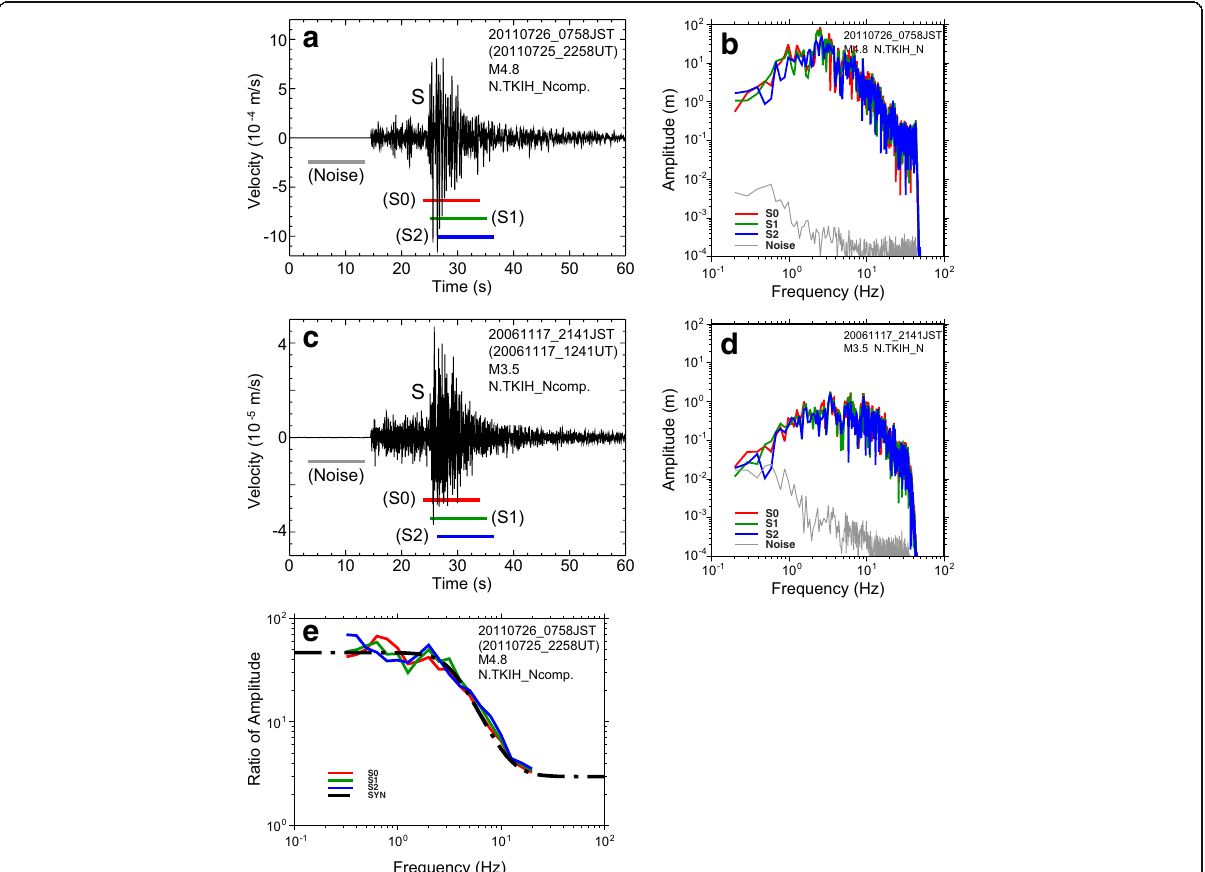
Fig. 3 a Example of an analyzed waveform of an earthquake with M4.8. The color lines indicate the three time windows used in deconvolution, which were (S0) − 0.50 to 9.73 s, (S1) 0.78 to 11.01 s, and (S2) 2.06 to 12.29 s after the S arrival. The gray line shows a time window from 12.00 to 1.77 s before the arrival time of the P wave, which was used to calculate the spectrum of a noise in ( b ). Each time window has 1024 data points. b Spectra of waveforms for the four time windows shown in ( a ). c Example of a waveform of an M3.5 earthquake that was used for an EGF. Note that the vertical scales in ( a ) and ( c ) are different. d Spectra of waveforms for the four time windows shown in ( c ). e Deconvolved spectra with the fitted omega-squared model. The color lines are deconvolved source spectra, that is, ( b ) divided by ( d ), for three individual time windows with a resampling of frequency bands. The black broken line shows the fitted omega-squared model with corner frequencies of 3.16 and 12.6 Hz for analyzed and EGF earthquakes,